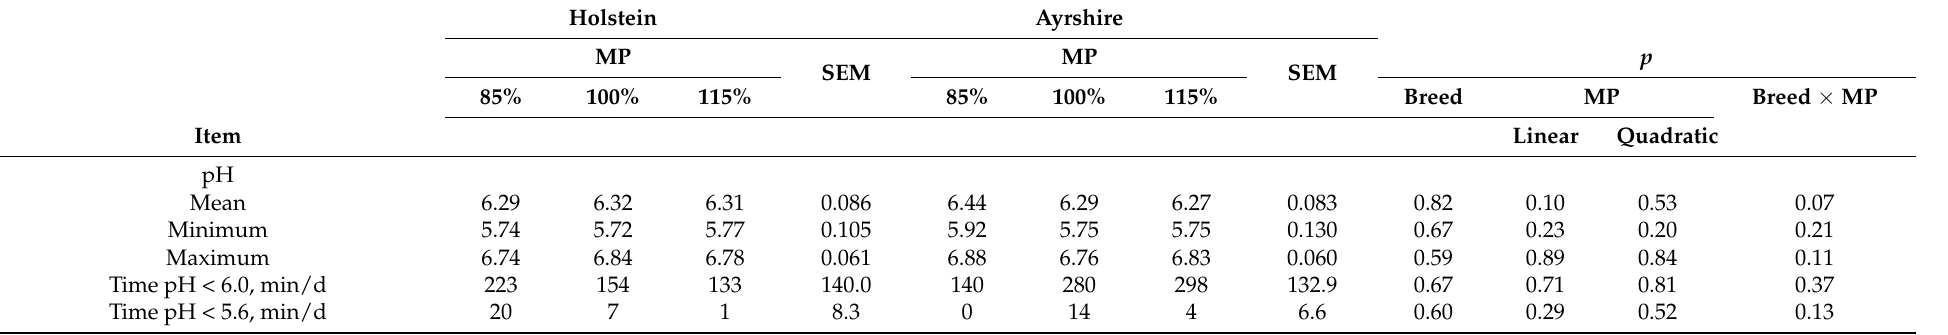
Table 3. Ruminal pH of lactating Holstein and Ayrshire cows fed diets formulated to provide 85%, 100%, or 115% of metabolizable protein (MP) requirement 1 .